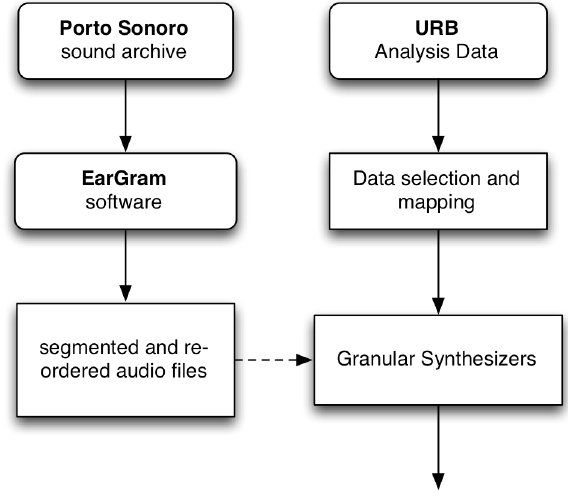
Figure 4 | Workflow